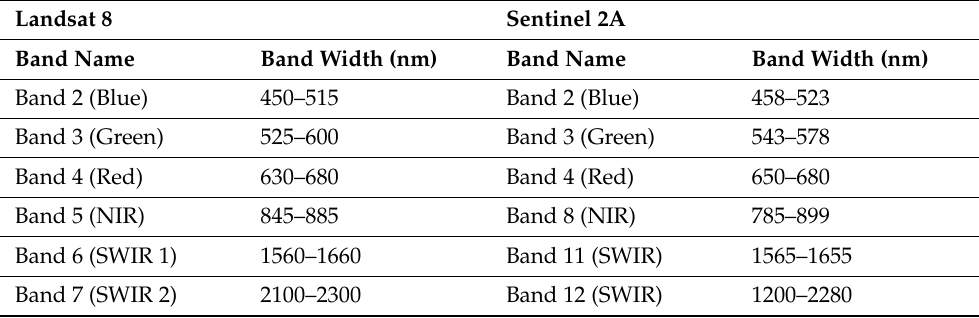
Table 1. Band width comparisons and translation from Landsat 8 to bands with similar reflectance information in sentinel 2A.